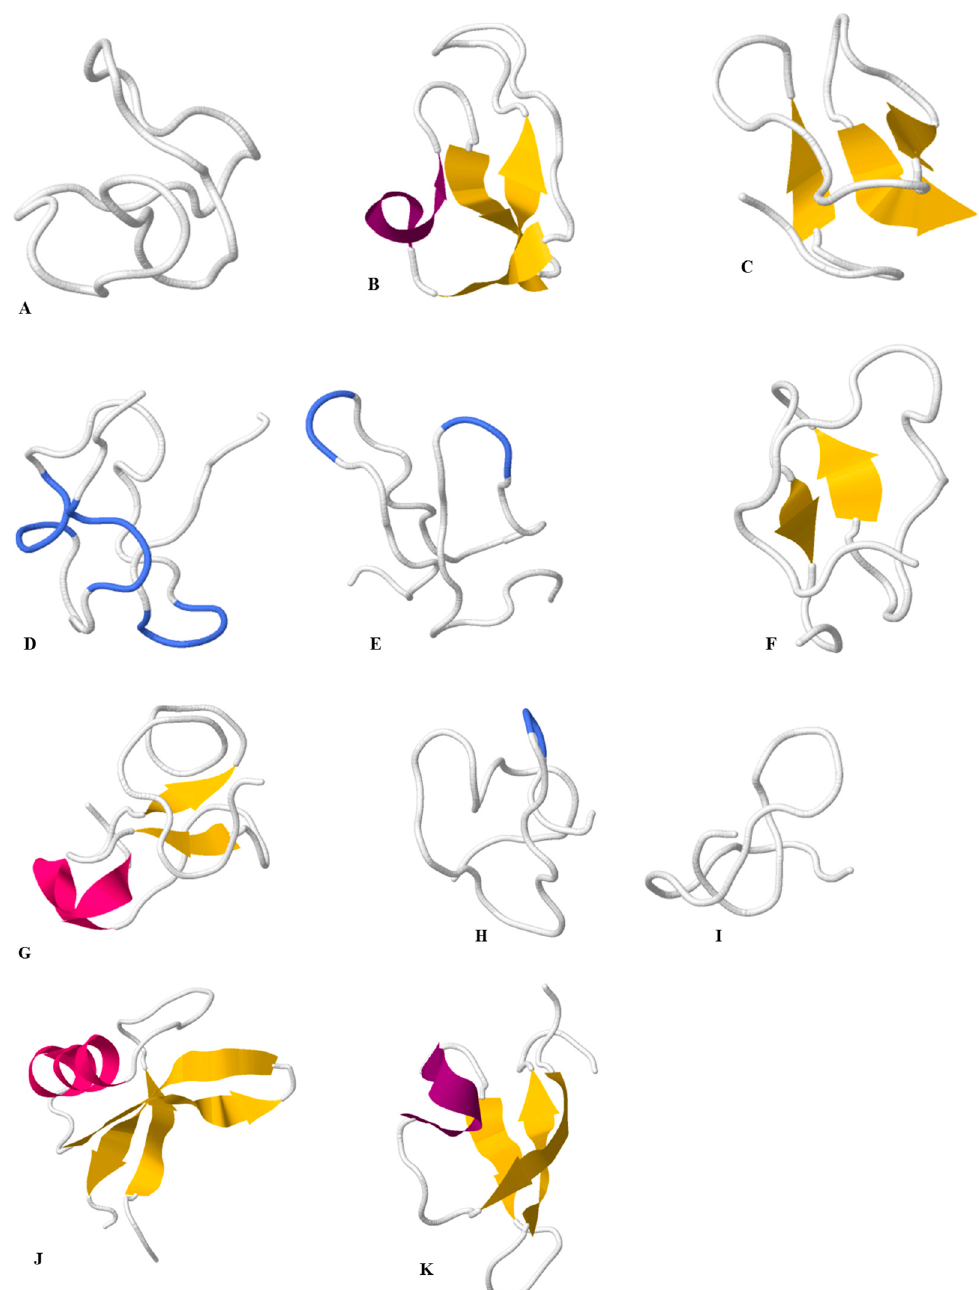
Figure 3. Molecular families of cystine knot peptides which include: ( A ) (PDB:1K48) Kalata B1 cyclotide from Oldenlandia affinis ; ( B ) (PDB:1HA9) disulphide-rich protease inhibitor (squash trypsin inhibitor MCOTI-II from Momordica cochinchinensis ); ( C ) (2MAU) alpha-amylase inhibitor wrightide R1 (wR1) peptide from Wrightia religiosa ; ( D ) (PDB: PDB:6JIC), carboxypeptidase inhibitor from Lycium barbarum ; ( E ) (PDB:5XBD) and ( F ) (PDB:2ML7) plant defensins, respectively, from Pereskia bleo and Panax ginseng ; ( G ) (PDB: 5XDI) Vaccatide, vH1- an antifungal Glutamine-rich 8C-Hevein-like Peptide from Vaccaria hispanica ; ( H ) (PDB: 5GSF) Roseltide rT1, a hydrolase inhibitor from Hibiscus sabdariffa ; ( I ) (PDB: 5XIV) Beta-Ginkgotides from Ginkgo biloba ; ( J ) (PDB: 2M8B) plant defensins AhPDF1 from Arabidopsis halleri ; ( K ) (PDB: 1P8B) Pea albumin peptide (PA1b), insecticidal peptide characterized from Pisum sativum